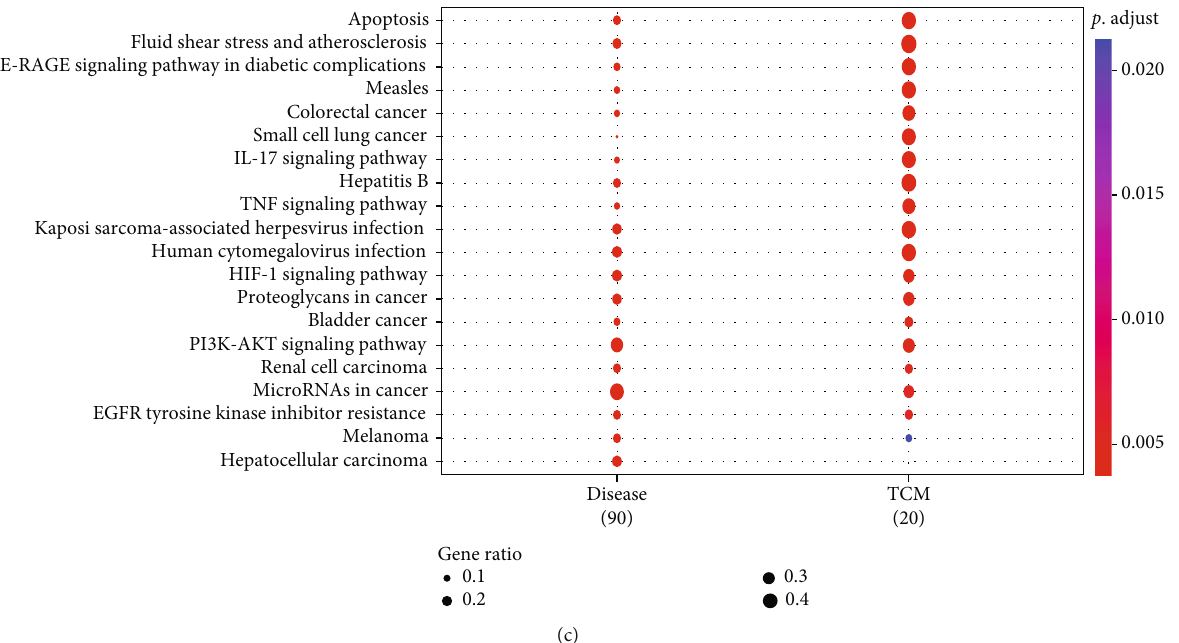
Figure 2: GO analysis and KEGG pathway analysis of the targets: (a) molecular function; (b) biological process; (c) KEGG pathway analysis. Note: GO: Gene Ontology; KEGG: Kyoto Encyclopedia of Genes and